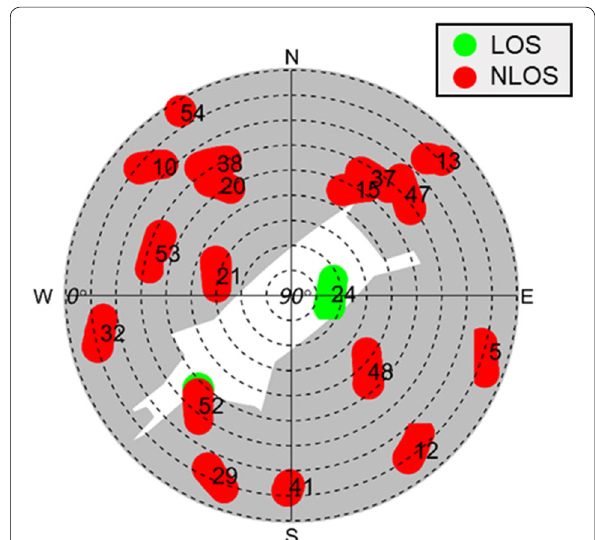
Fig. 15 Sky plot from ground truth label at P7